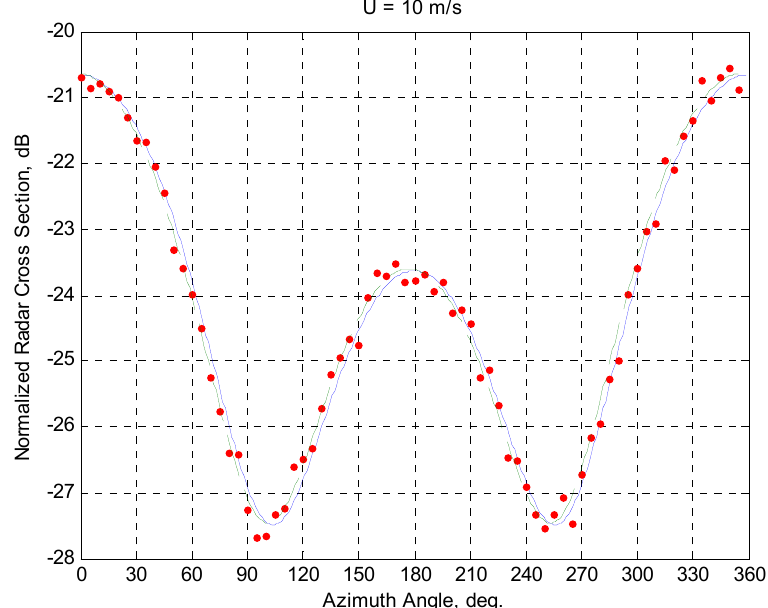
Figure 7. Azimuth NRCS curve using Equation (1) at the incidence angle of 45 ˝ , “true” wind speed of 10 m/s and “true” up-wind direction of 0 ˝ (solid line); generated “measured” NRCS with taking into account the instrumental noise of 0.2 dB after the averaging of 1565 samples in a five-degree azimuth sector (red dots); and azimuth NRCS curve using Equation (1) corresponding to “measured” wind speed of 10.0279 m/s and up-wind direction of 357.3 ˝ retrieved from the azimuth sector of [90 ˝ , 270 ˝ ] (dashed